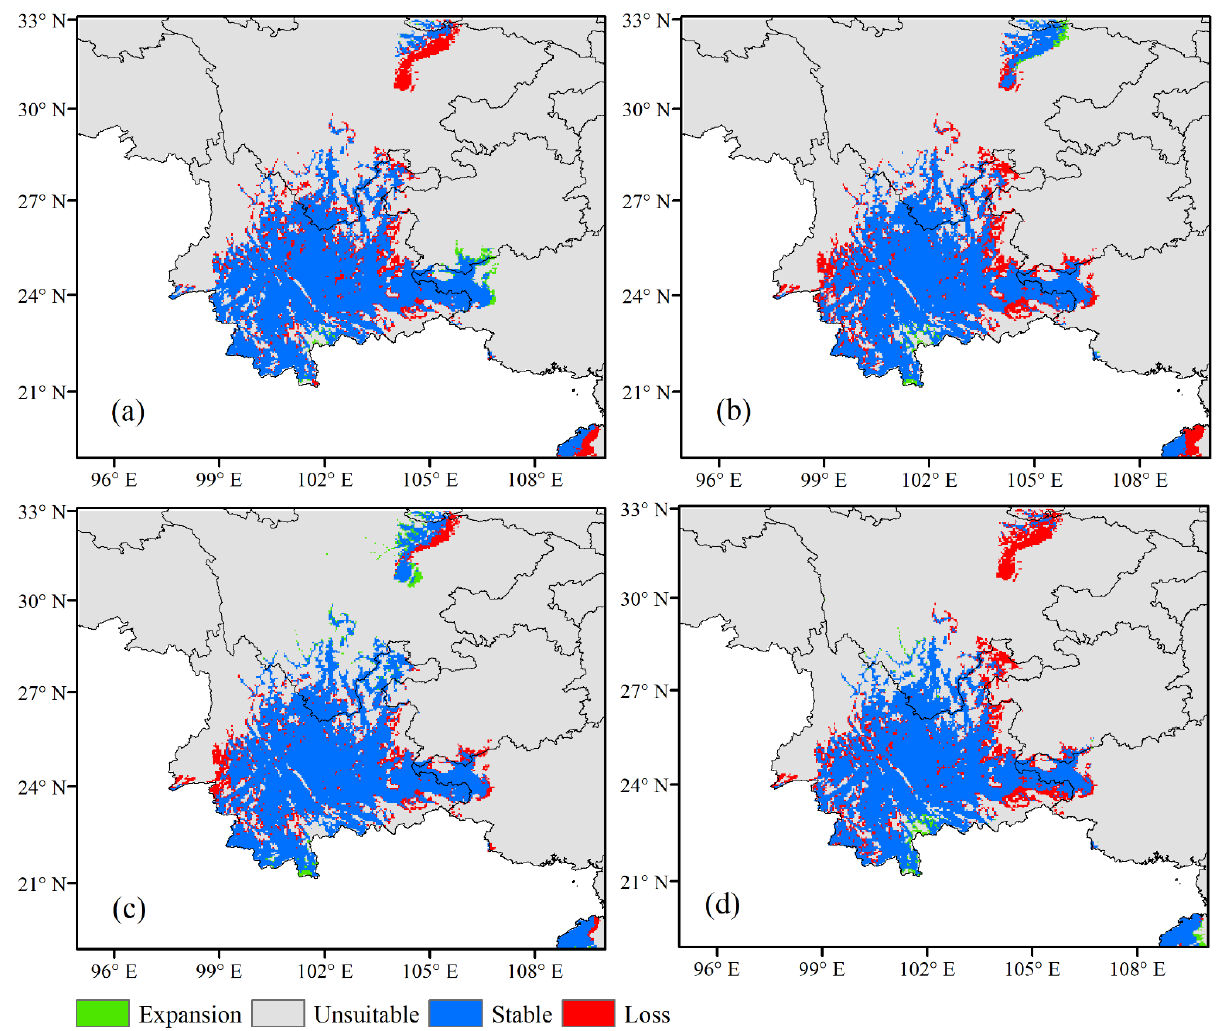
Figure 5. Predicted shifts of ranges in habitat suitability of Garuga forrestii as projected by MaxEnt models between current and future climate scenarios. ( a ) RCP4.5 scenario (2050), ( b ) RCP8.5 scenario (2050), ( c ) RCP4.5 scenario (2070) and ( d ) RCP8.5 scenario (2070). Green shows areas that will become suitable in the future; blue areas are expected to remain unchanged under future climates. In contrast, the red regions are expected to become unsuitable in the future.